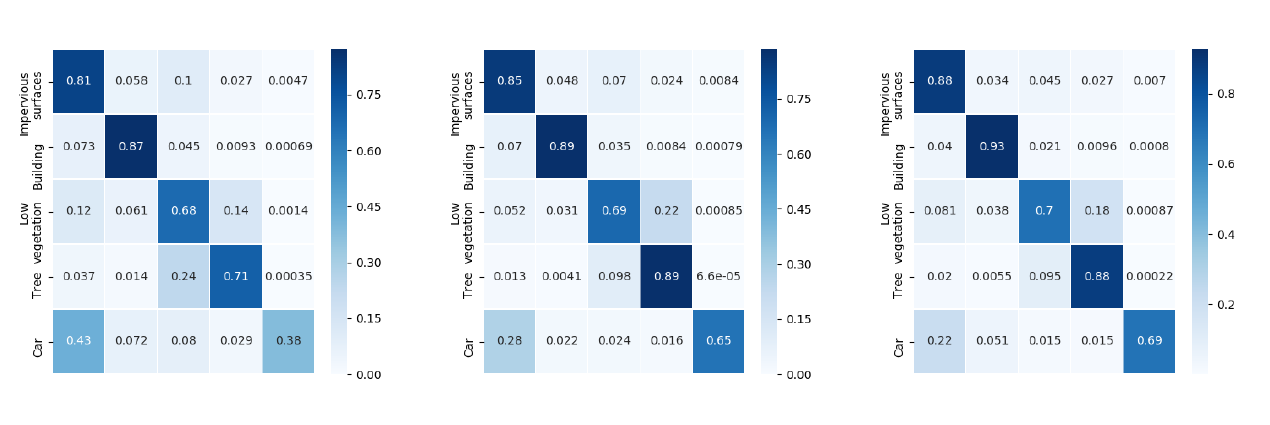
Figure 2. Confusion matrices for the Vaihingen dataset with 8 × degradation. From left to right: (i) Segnet trained with LR inputs, (ii) end-to-end framework, (iii) Segnet trained with HR inputs.